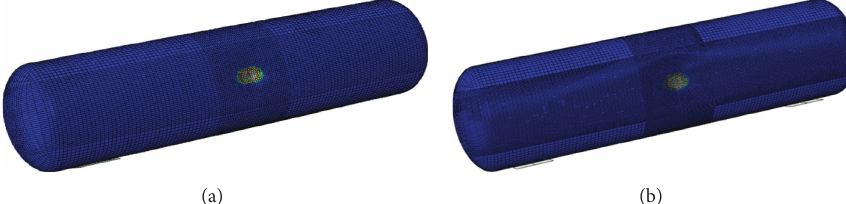
Figure 10: Another illustration of the mitigation of mesh size effects in the FE simulations of hazmat tank car using nonlocal BCJ model. The figures show the damage pattern on the outer surface of the tank body located in the impact region for coarse (a) and fine (b) meshes at the same time. Note the similarity between the damage